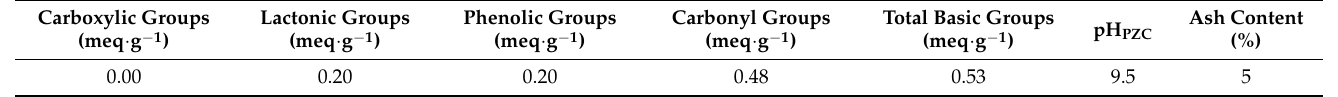
Table 2. Results of Boehm titration, pH PZC and ash contents of AC.